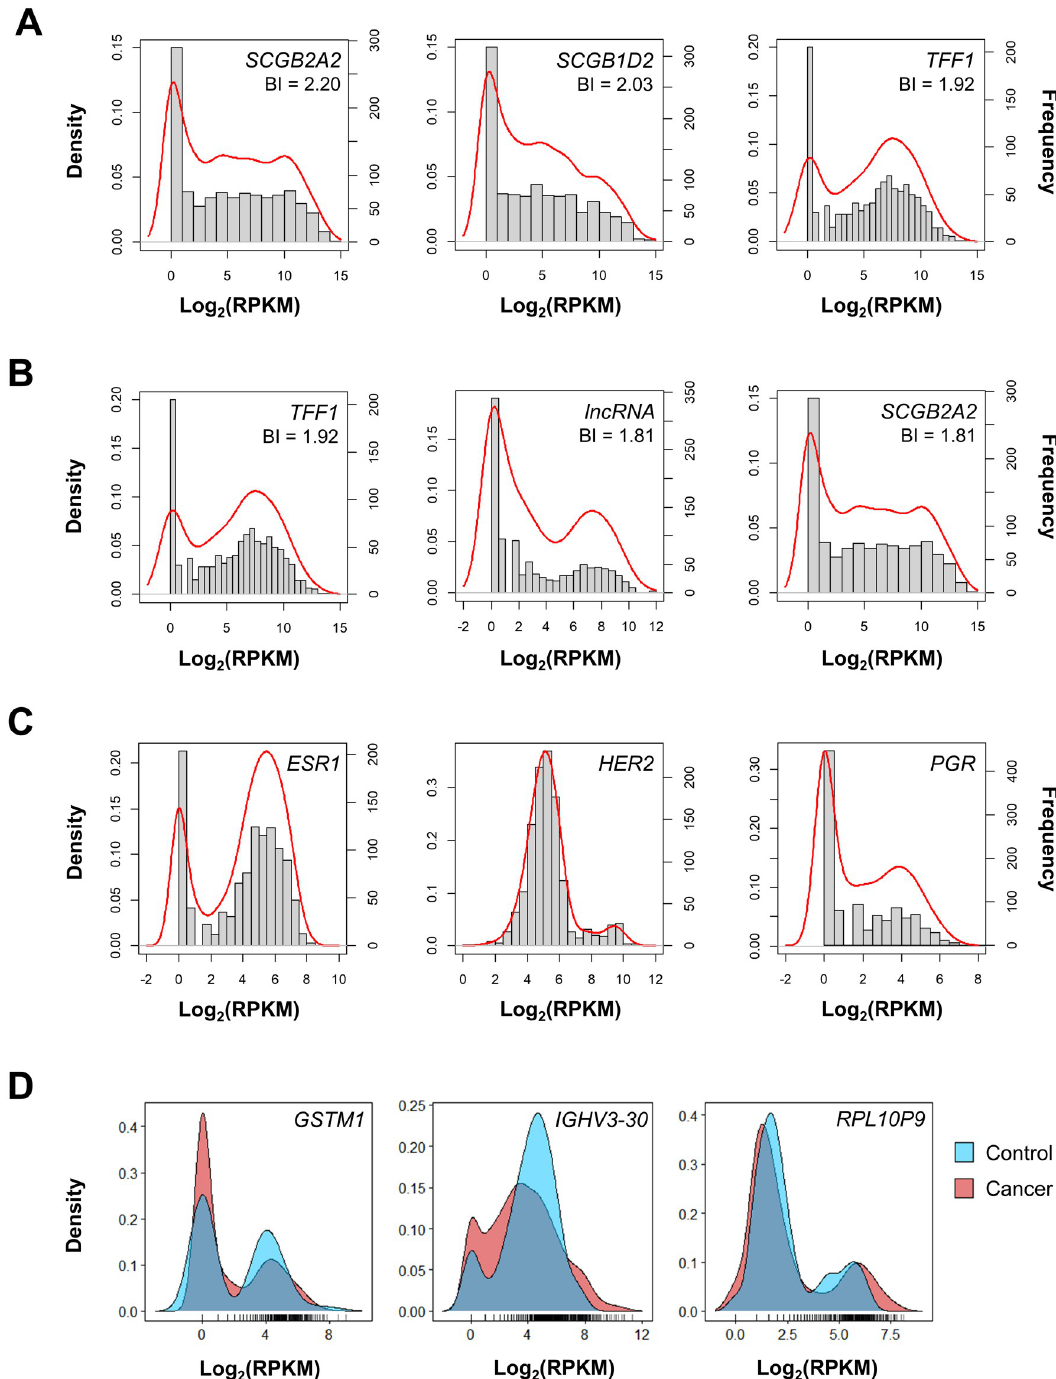
Fig 2. Methodology validation. Breast cancer RNA-seq data were clustered using (A) mixture modeling (MM) and (B) controlled mixture modeling (CM). The bimodality index was calculated and the top three genes using each method are reported. (C) ESR1 , HER2 , and PGR are known to follow a bimodal distribution among breast cancer patients. The plots show gene expression in log 2 (RPKM) on the x-axis. Density is represented by the red line (left y-axis) and frequency is represented by the gray bars (right y- axis). (D) CM excluded genes with similar distributions in cancer and control. GSTM1 , IGHV3-30 , and RPL10P9 were identified by MM but excluded by CM at BI > 1. Density is shown for cancer (red) and control (blue) samples.